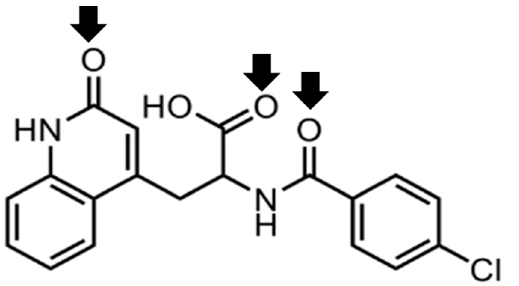
Scheme 1. The chemical structure of RB. The black arrows are the carbonyl group focused on in FTIR.